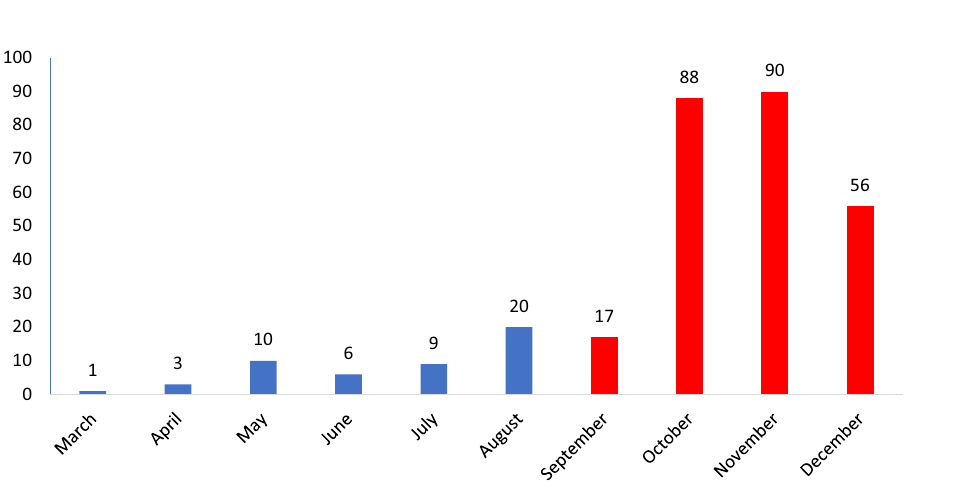
Figure 1. The number of reported COVID-19 cases in infants diagnosed in the subsequent months of 2020, divided into two waves of the